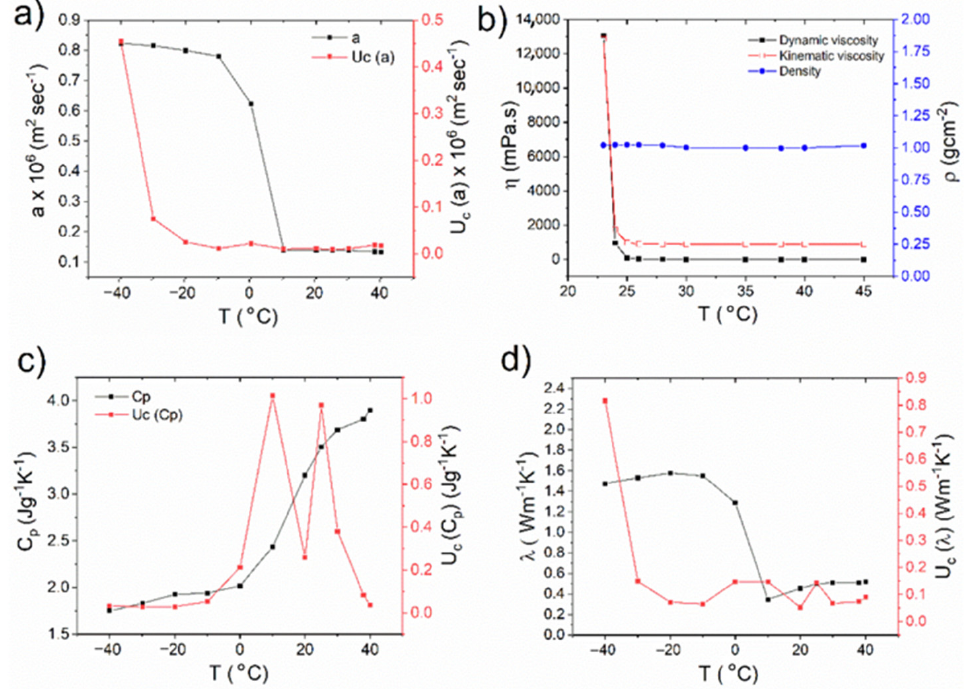
Figure 1. The thermophysical properties of the Gel-10% solution: ( a ) Thermal diffusion density; ( b ) viscosity; ( c ) specific heat; ( d ) calculated thermal conductivity with their corresponding measure- ment uncertainties ( U c ).